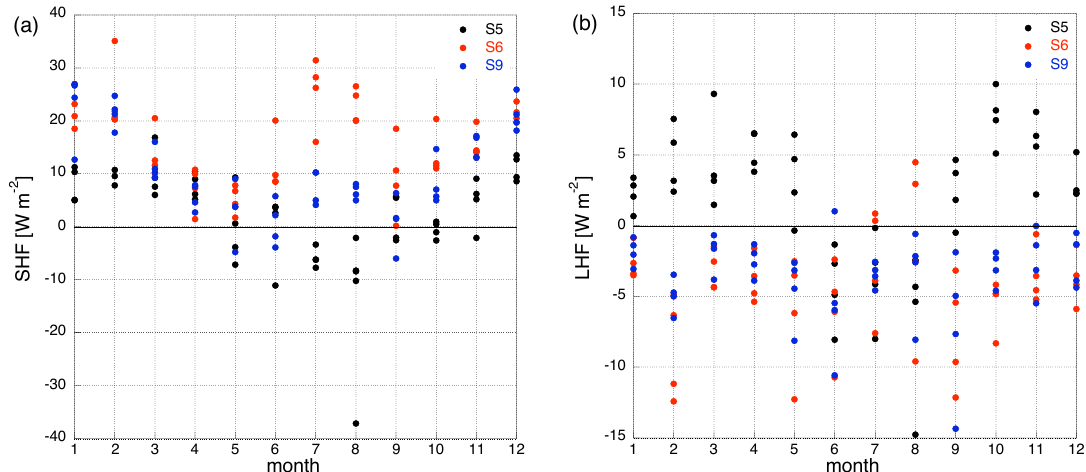
Fig. 15. Monthly model bias for (a) sensible heat flux SHF, and (b) latent heat flux LHF for S5 (black), S6 (red) and S9 (blue) along the K-transect [Wm − 2 ] over the period August 2003–August